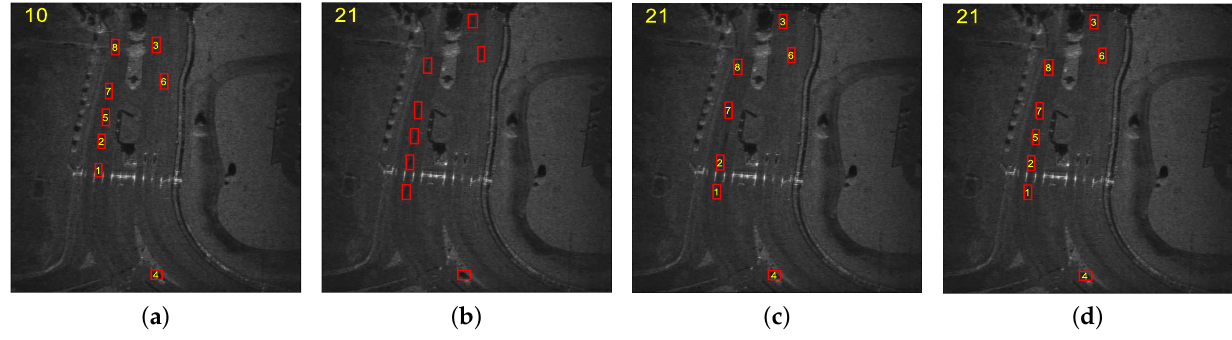
Figure 27. Tracking results of the proposed method when the target is obscured in consecutive frames. Target 5 is undetected from frame 11 to frame 20. ( a ) Tracking results at frame 10. ( b ) Detection results at frame 21. ( c ) Tracking results at frame 21 when Max_age is 9. Target 5 fails to be re-tracked. ( d ) Tracking results at frame 21 when Max_age is 11. Target 5 is re-tracked successfully.